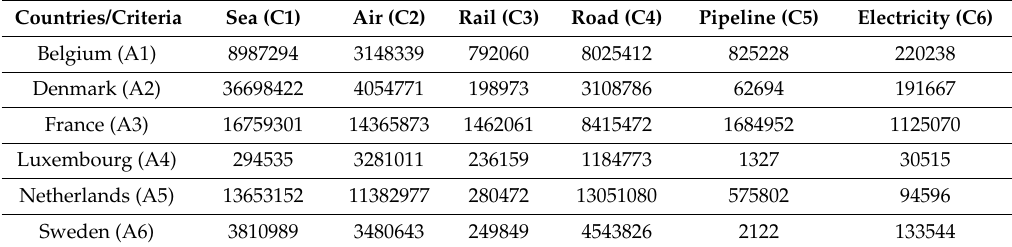
Table A3. Selected Data of Transport Export for the EU by 2014 (US Dollar, Thousand).